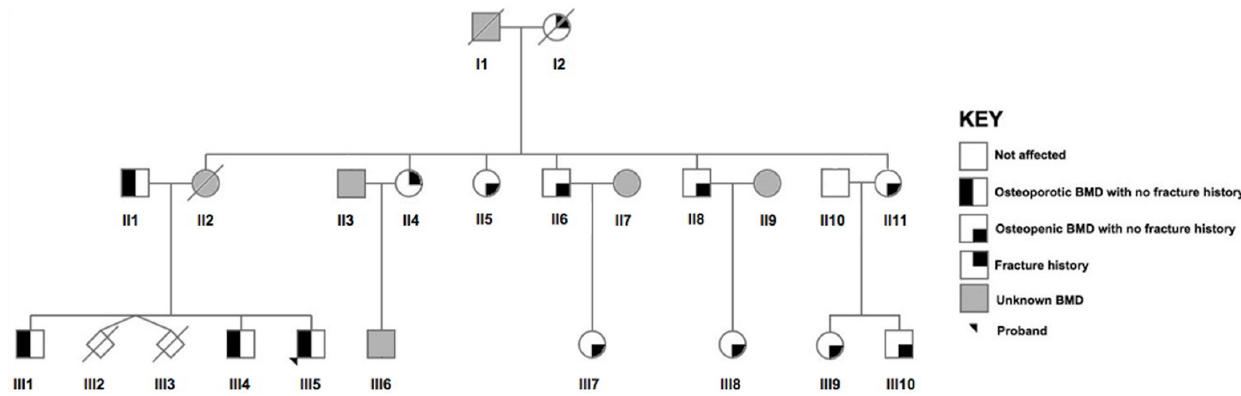
Figure 1. Pedigree of the two-generation Maltese family. Roman numerals indicate generation, whereas Arabic numbers indicate the order. The arrow indicates the proband. Squares represent male relatives, females are depicted in circles, whereas diamonds signify a stillbirth with an unknown gender. Gestational age of the latter is unknown. A diagonal arrow indicates that the individual is deceased and no biological material was available for analyses. A half black symbol represents the presence of osteoporosis, whereas a quarter shading represents osteopenia or a low-trauma fracture history. Relatives with no bone mineral density (BMD) measurements are shaded in grey and marked as ‘unknown’. Table 1. Clinical characteristics of the recruited relatives.